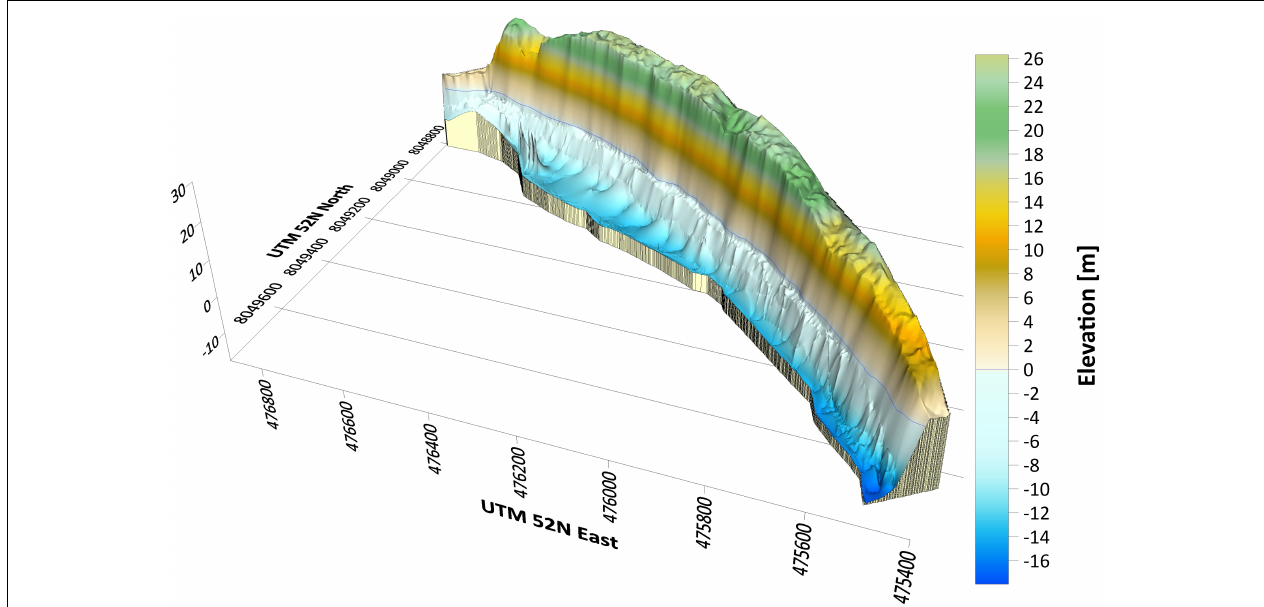
FIGURE 4 | 3D-view of combined topographic and bathymetric surveys at Sobo-Sise Cliff in August 2016 showing cliff height configuration and steep bathymetric gradients directly off the